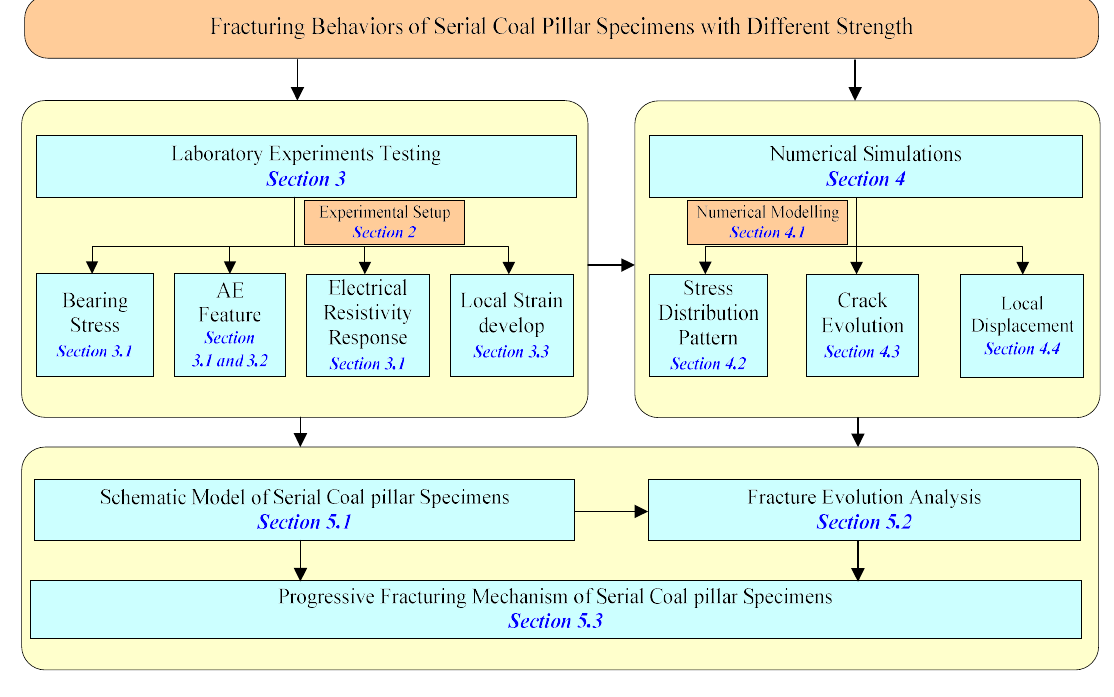
Figure 1. Overview of research flowchart.